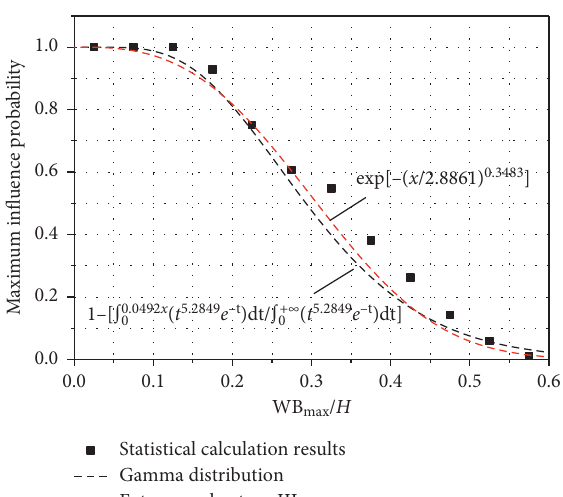
Figure 24: Fitting results of the maximum influence probability of the debris accumulation distribution along the Z axis under the continuous collapse.